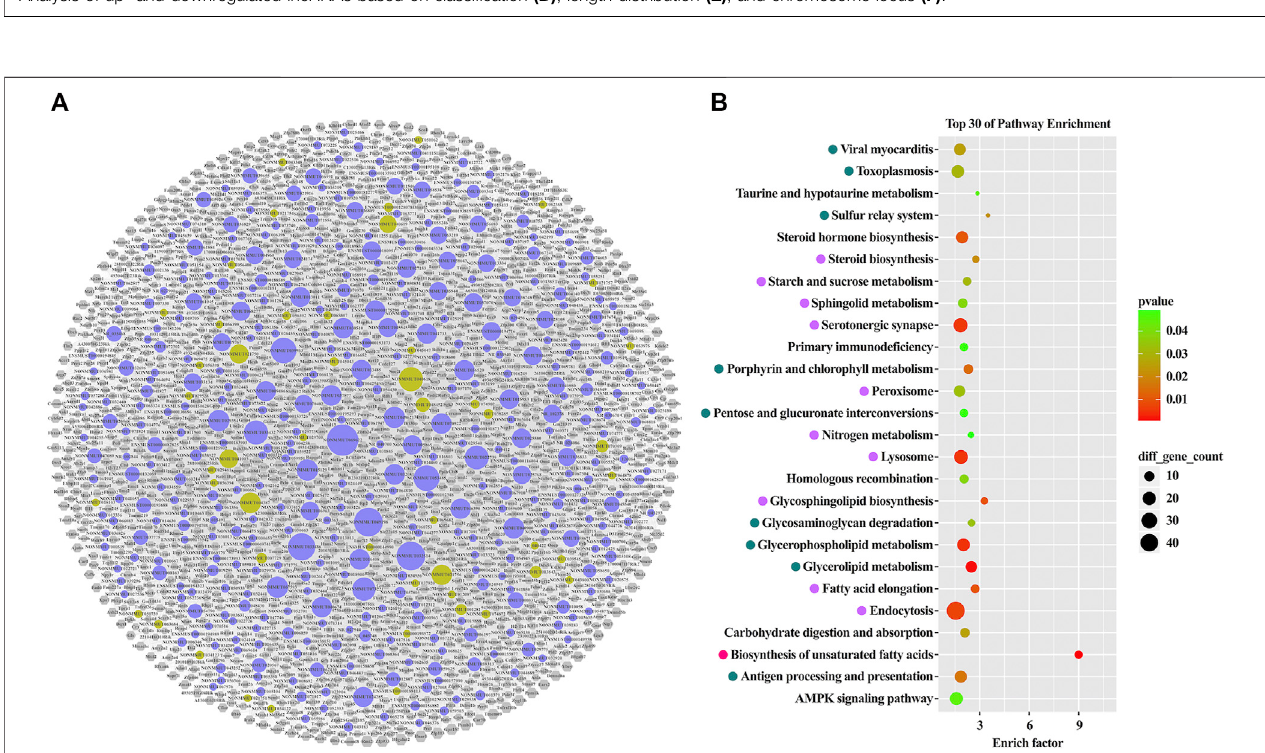
FIGURE 4 | Construction of the lncRNA-target genes interaction network and pathway analysis of the target genes. (A) lncRNA-target genes interaction network. Circle nodes with strong yellow and orchid represent up- and downregulated lncRNAs, respectively. Hexagon nodes with gray represent target genes. (B) Top 30 signi fi cantlyenriched pathways rankedwithanenrichmentscore( p < 0.05).Trans-, CIS-, and transand CIS-regulatorypathwaysaremarkedwithlightviolet,darkcyan, and pure pink, respectively.